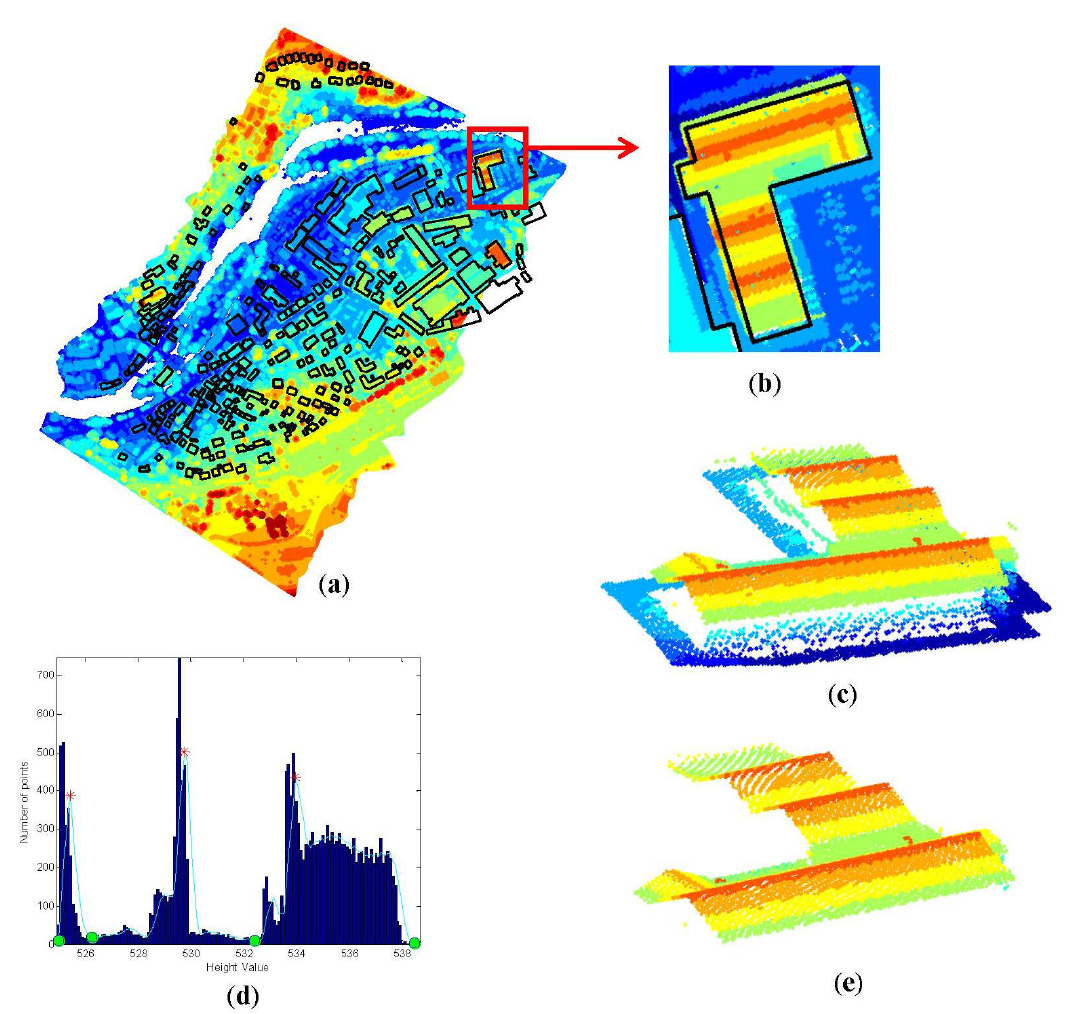
Figure 5. Extracting roof points aided by OpenStreetMap (OSM) footprints data. ( a ) LAS point clouds overlapped with OSM footprints. ( b ) offset between building points and OSM footprint. ( c ) building points extracted with help of OSM building footprint. ( d) histogram analysis ofextracted building points along height. ( e ) final result of extracted roof